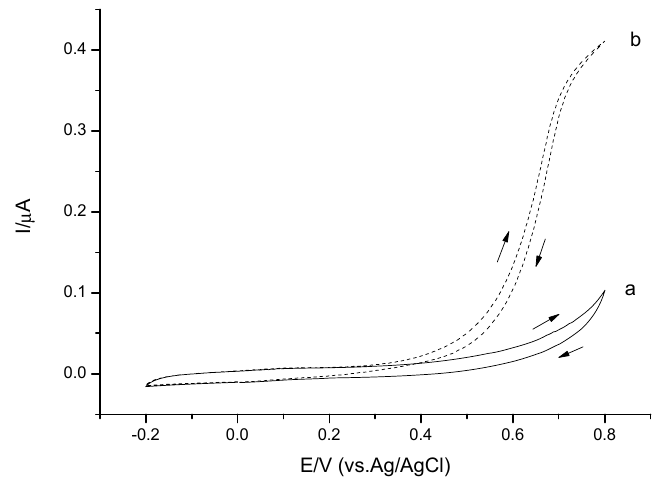
Figure 2. Cyclic voltammograms of CSPEs in 0.1 M phosphate buffer solution, pH 7.5 (a); O (b). Scan rate 20 mV·s − 1 in presence of 1 mM H 2 2